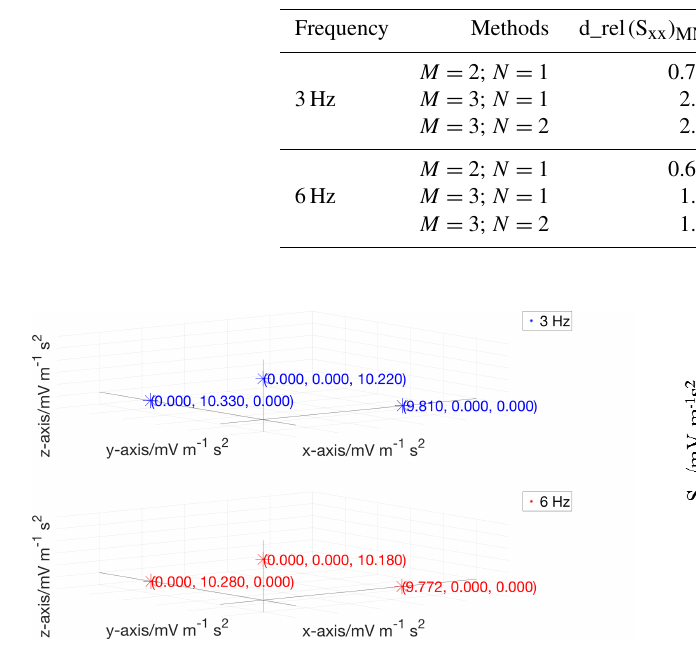
Figure 10. Piezo-electric accelerometer: comparison between methods (main sensitivity along the x axis, S xx